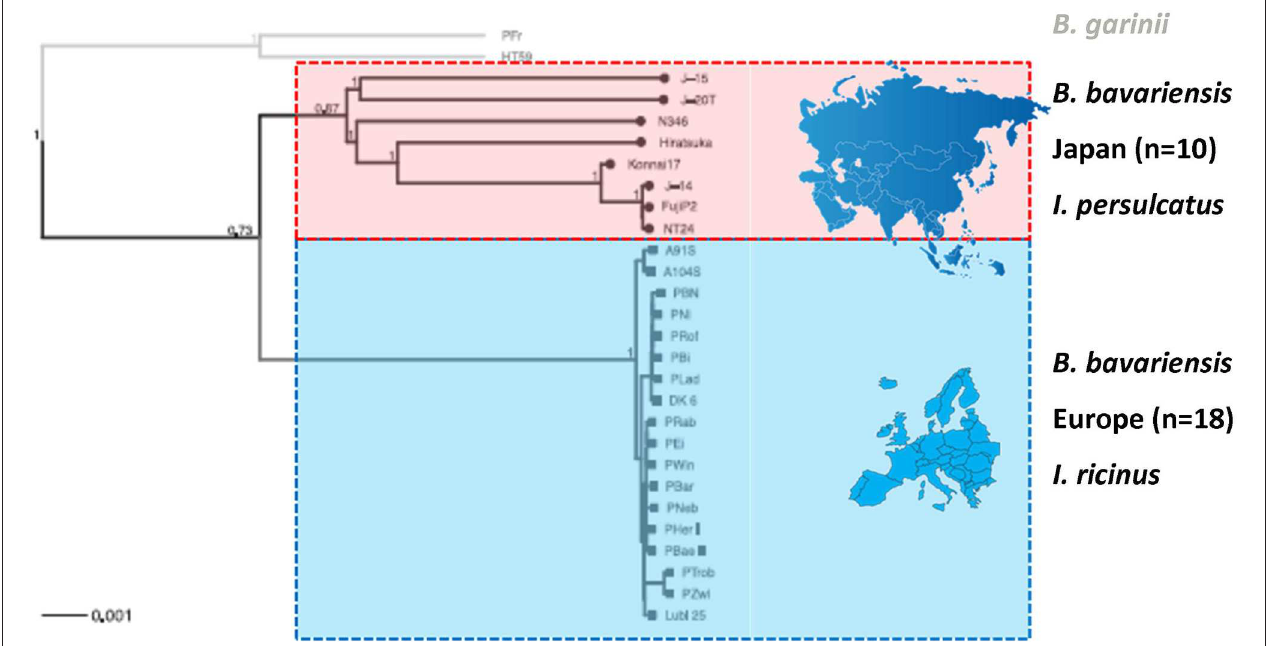
FIGURE 4 | Phylogeny of B. bavariensis from Asia and Europe. The tree was generated using chromosomal single nucleotide polymorphisms. Taxa included are B. bavariensis from I. persulcatus (Japan) and I. ricinus (Europe) dominated regions. The genetic homogeneity in European B. bavariensis stands in strong contrast with the genetic heterogeneity of B. bavariensis from Asia. B. garinii isolates were used as outgroup. The scale bars are expressed in units of substitution per site. With permission from Gatzmann et al. (2015), Ticks and Tick-borne Diseases 6,